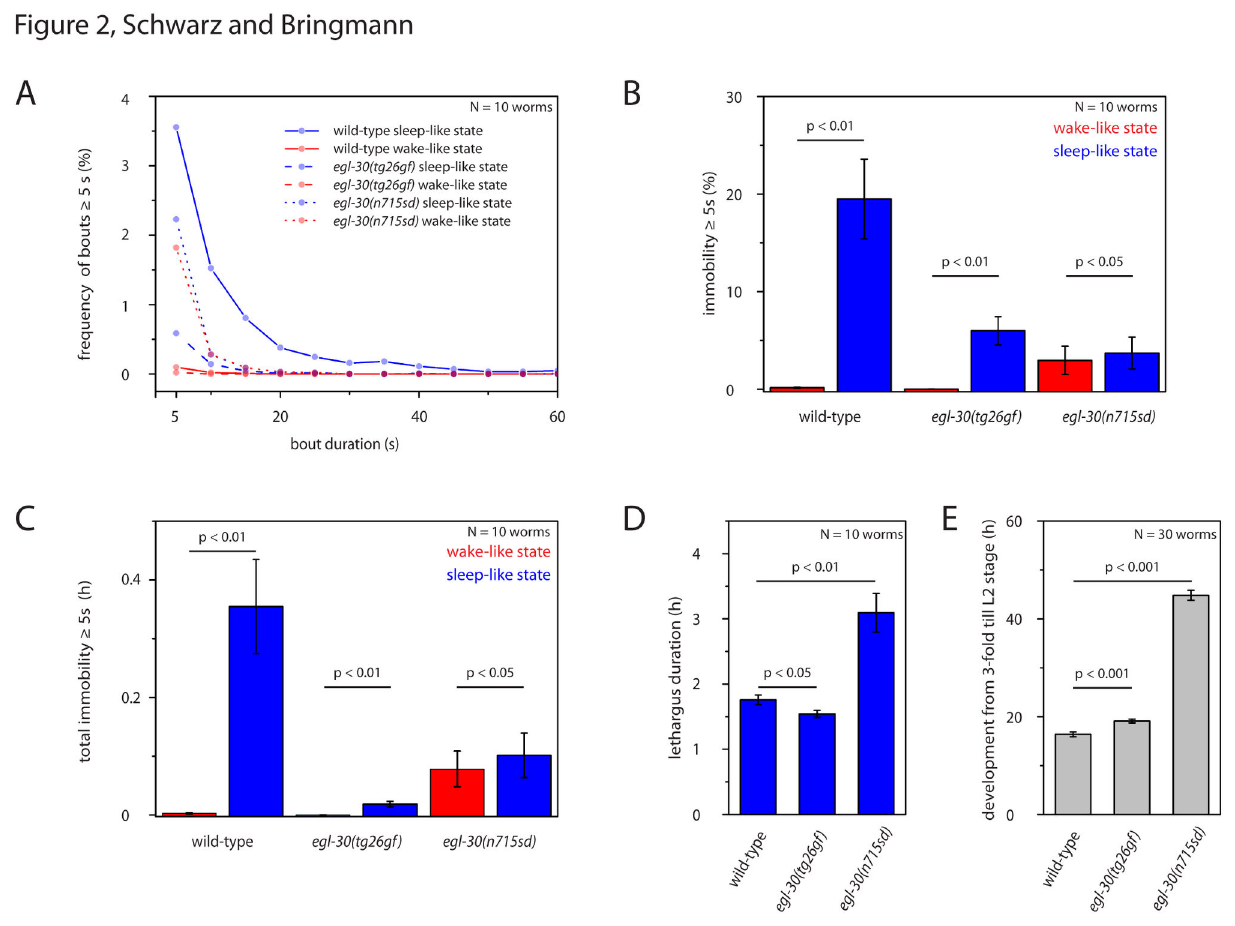
Figure 2. Quiescence bout lengths in egl-30 mutants. A Frequency distribution of quiescence bout durations for wild type and egl-30 mutants calculated as the fraction of lethargus length (or a time window of 2h during wake-like behavior). A bout was defined as immobility lasting 5s or longer. B Quantification of total immobility ≥ 5s calculated as a fraction of lethargus length (or a time window of 2h during wake-like behavior). C Cumulative immobility ≥ 5s integrated over the entire lethargus phase (or a time window of the same length during wake-like behavior). D Mean lethargus duration in hours as defined by the absence of pharyngeal pumping. E Mean development time in hours from 3-fold embryo until L2 larvae in wild type and egl-30 mutants. Error bar represent SEM. A paired sample Wilcoxon test was used for statistical testing of wake-like versus sleep-like behavior. T-test was used for comparing different